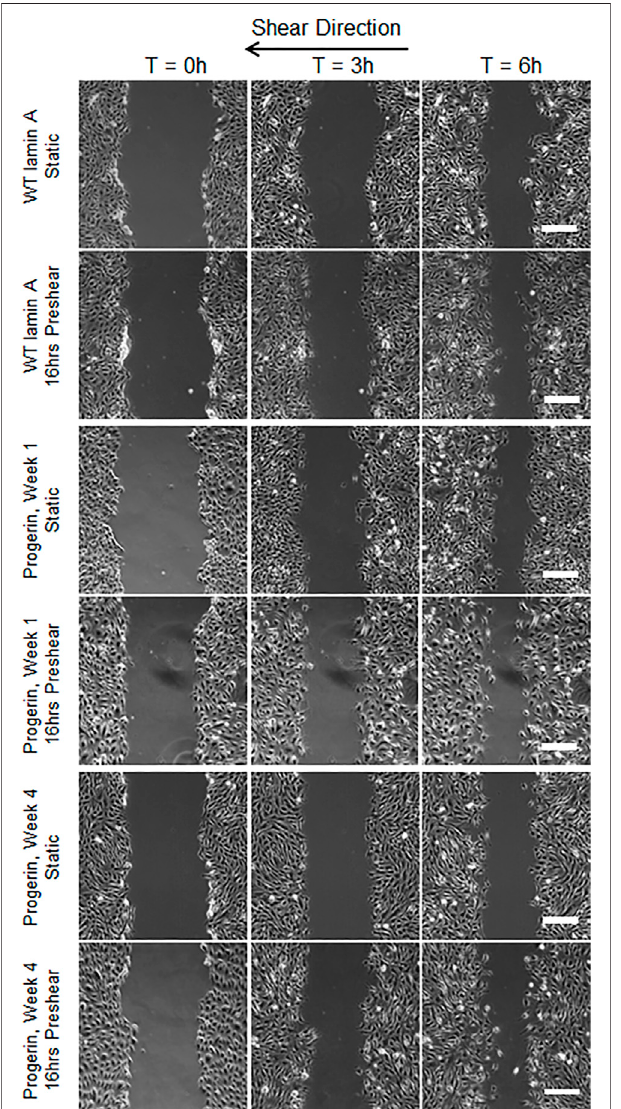
FIGURE 2 | Representative images of wound healing process with or without 16-h-preshearing condition. Wounds were formed following fl ow application, and images were taken for the next 6 h. Images taken at time points of 0, 3, and 6 h were shown in different columns. Scale bar: 200 µm.